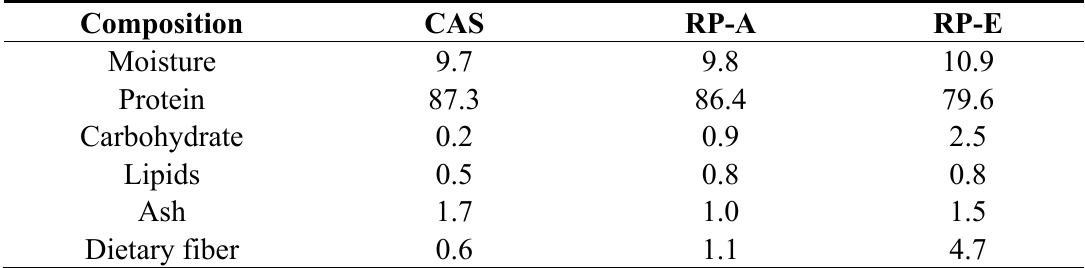
Table 2. Composition of dietary proteins (%).